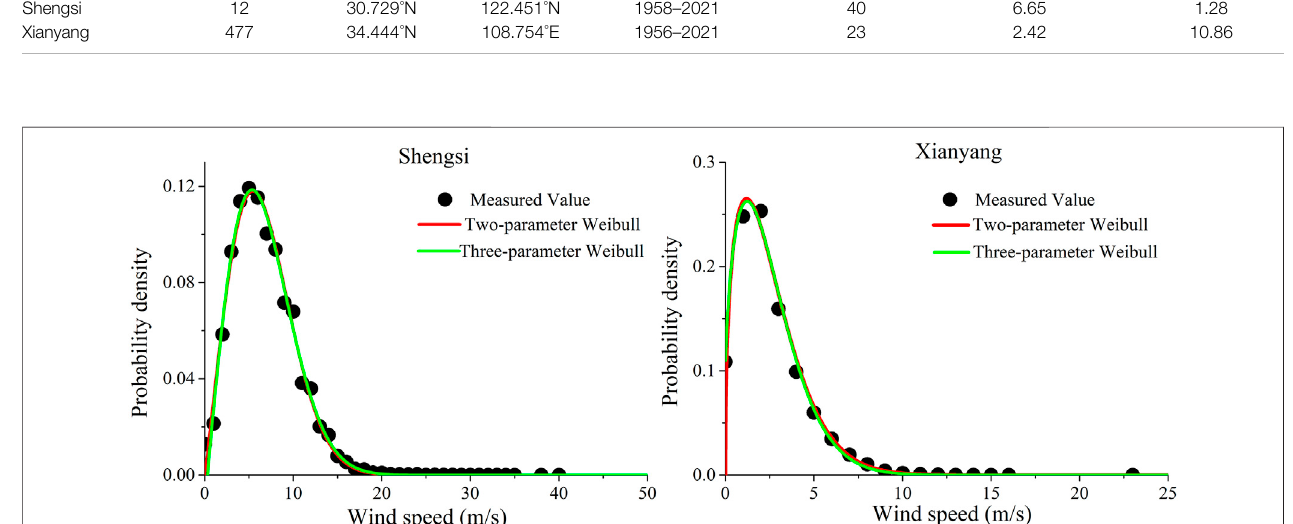
FIGURE 4 | Fitting curves of two-parameter Weibull distribution and three-parameter Weibull distribution at Shengsi and Xianyang sites.